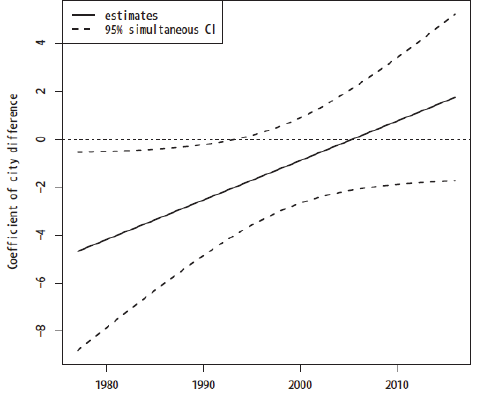
Fig. 19. A grouped time trend of city effects on keyword's appearance when K=3